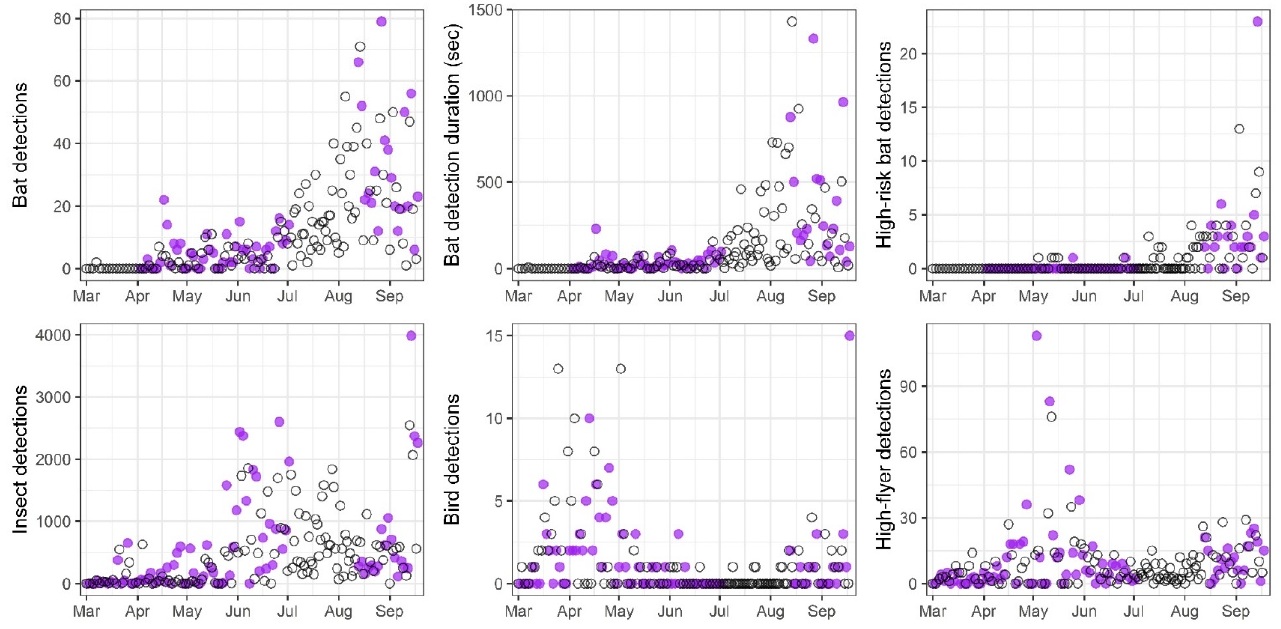
Figure 6. Response to UV illumination on nights with (purple circles) and without UV (open circles) treatment based on counts of bats (all detections, cumulative duration of detections, and high-risk detections), insects, birds, and “high-flyers”.